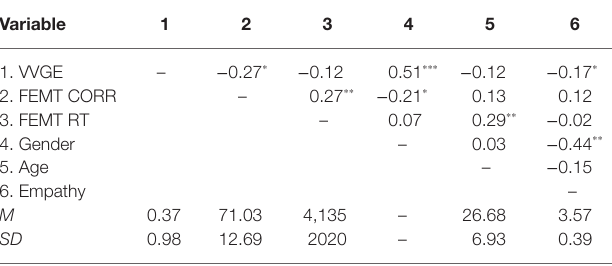
TABLE 3 | Means, SD, and correlations between violent game playing time and additional variables in Study 2 ( N = 151).